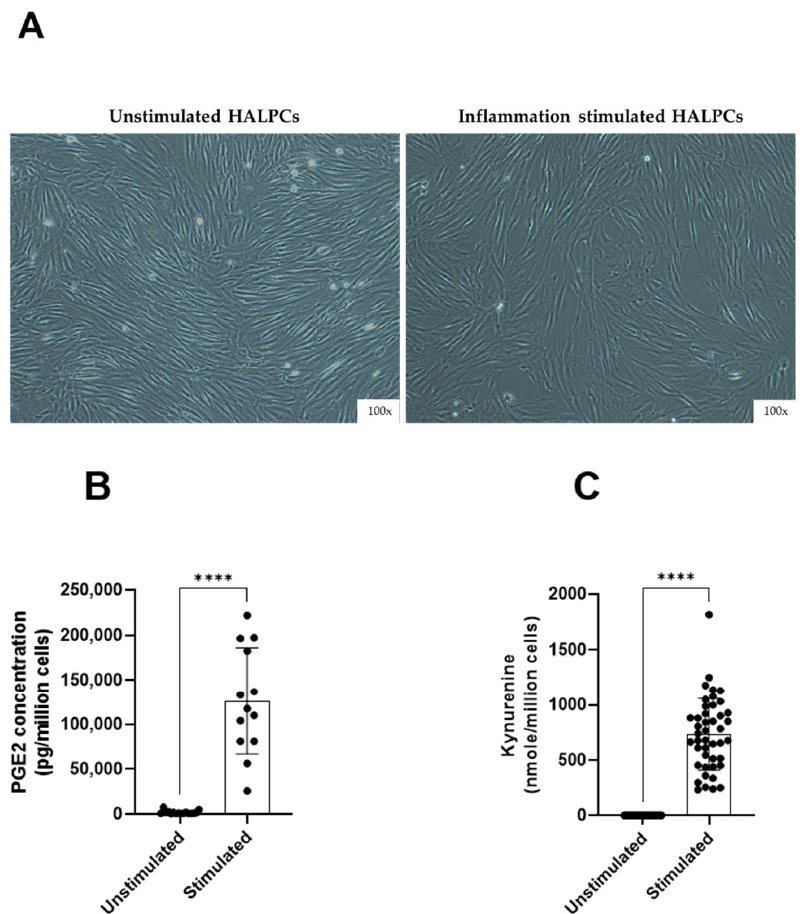
Figure 1. Secreted levels of immunomodulatory factors by HALPCs. ( A ) Morphology of HALPCs (representative sample) observed microscopically after treatment with the cocktail of proinflammatory cytokines ( n ≥ 3 samples from different donors). Magnification: 100×. ( B ) Prostaglandin E2 (PGE2) secreted levels. ( C ) IDO activity represented by kynurenine secretion in the CM of HALPCs). Unstimulated: absence of pro-inflammatory cytokines ( n = 16); stimulated: presence of pro-inflammatory cytokines ( n ≥ 13). ****: p < 0.0001 (Unpaired t -test).